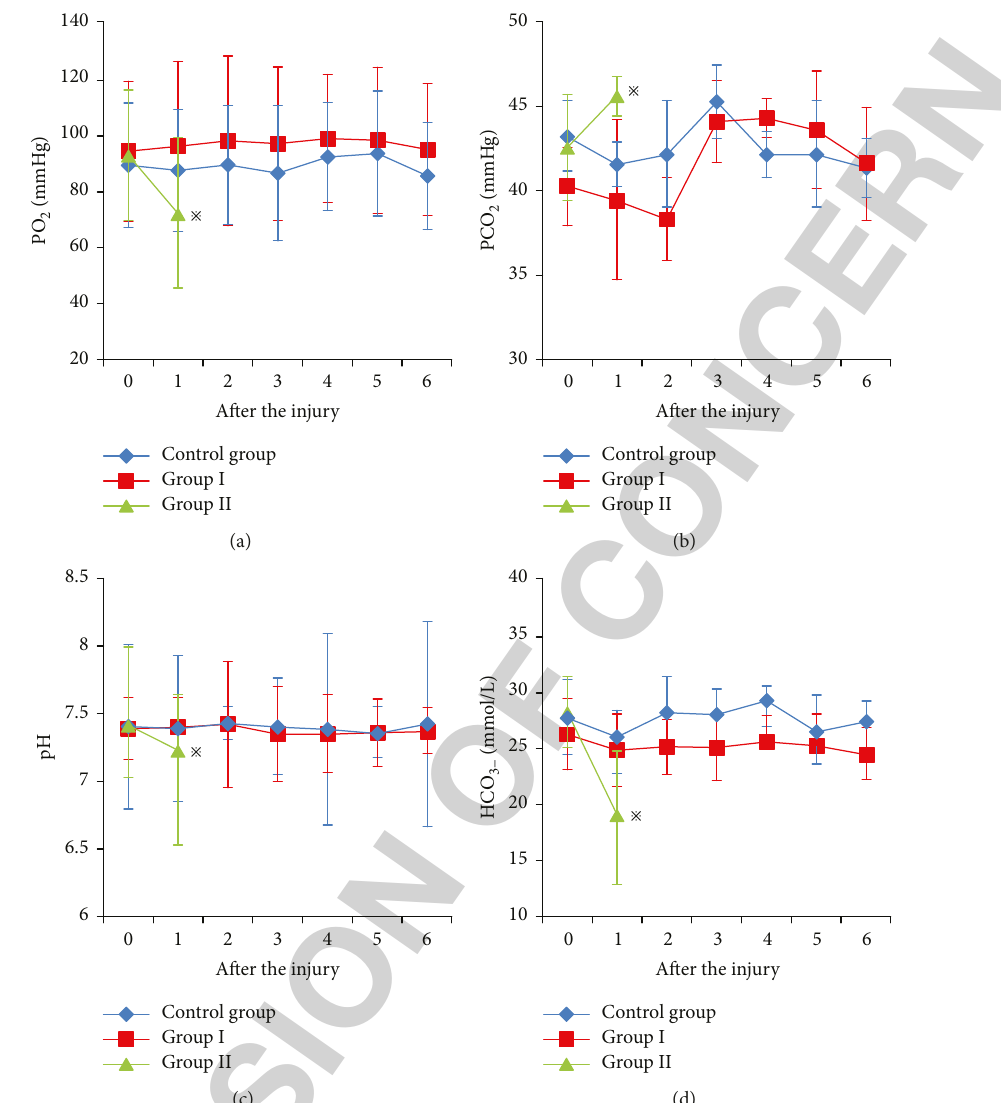
Figure 5: Arterial blood gas analysis. (a) PO , (b) PCO , (c) pH, and (d) HCO 2 2 (PCO , PO , pH, and HCO ) at 1h compared with baseline and control group, p < 0 05 2 2 3 −